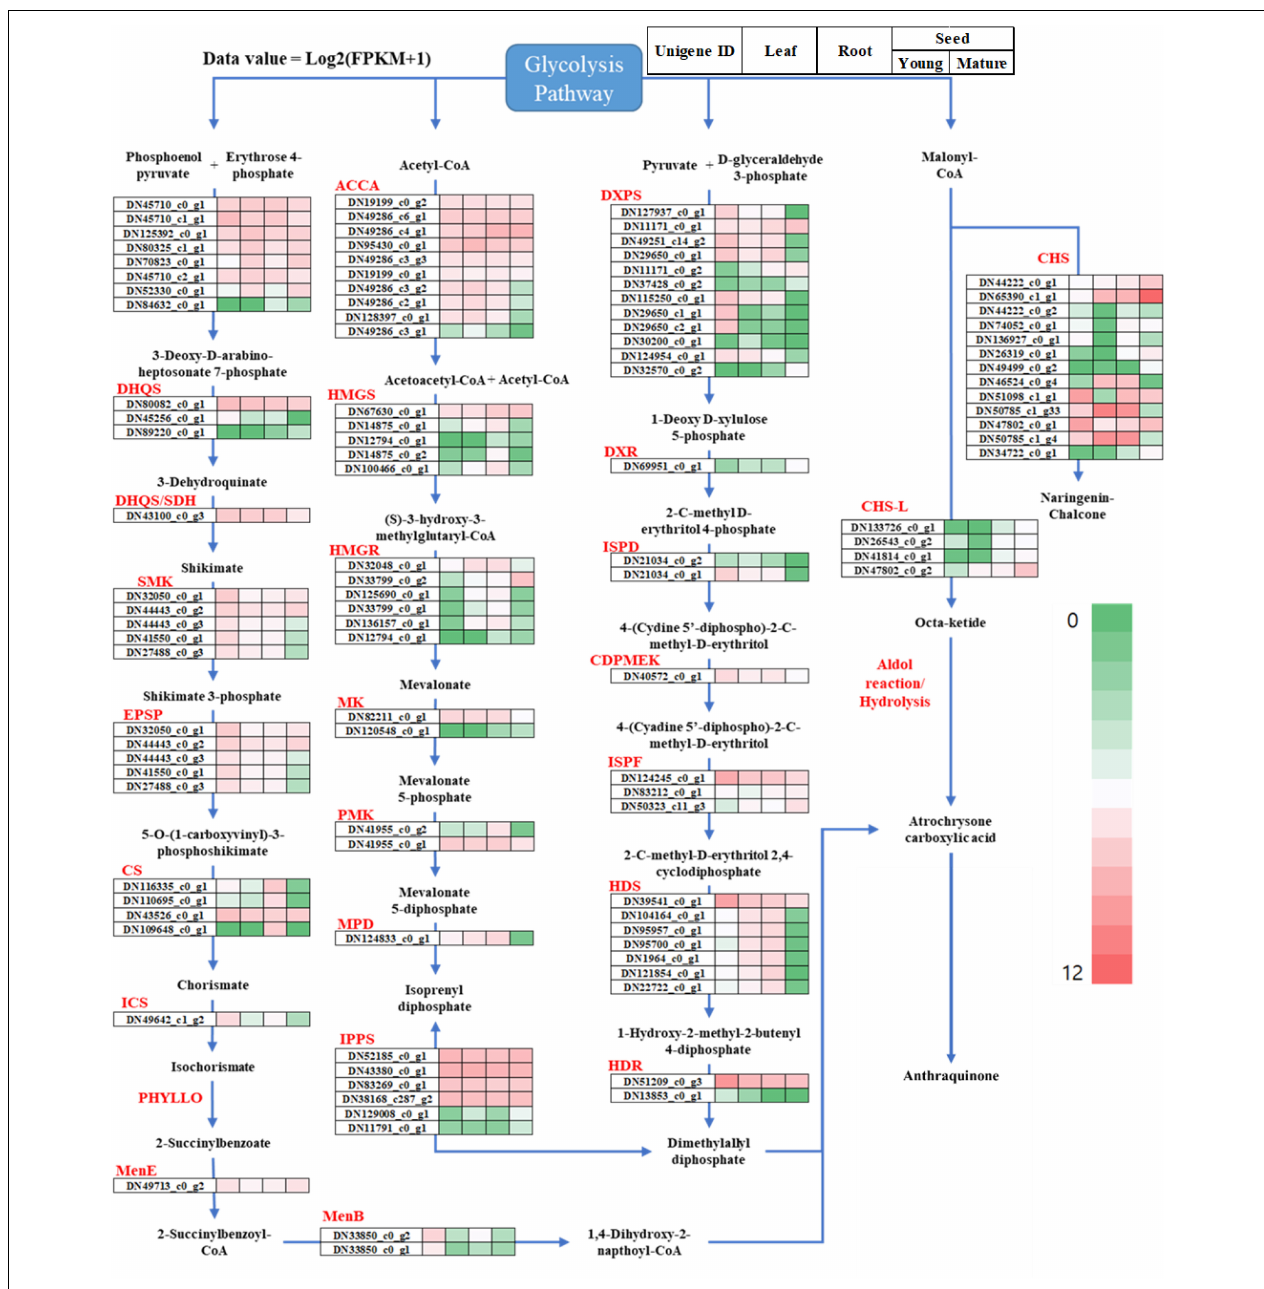
FIGURE 5 | Overview of the putative anthraquinone biosynthesis pathway genes in Senna occidentalis. The gene expression levels were normalized to the fragments per kilobase of transcript per million reads (FPKM) values to compare the changes in expression between different tissues of S. occidentalis . The total gene expression levels were clustered based on log 2 (FPKM +